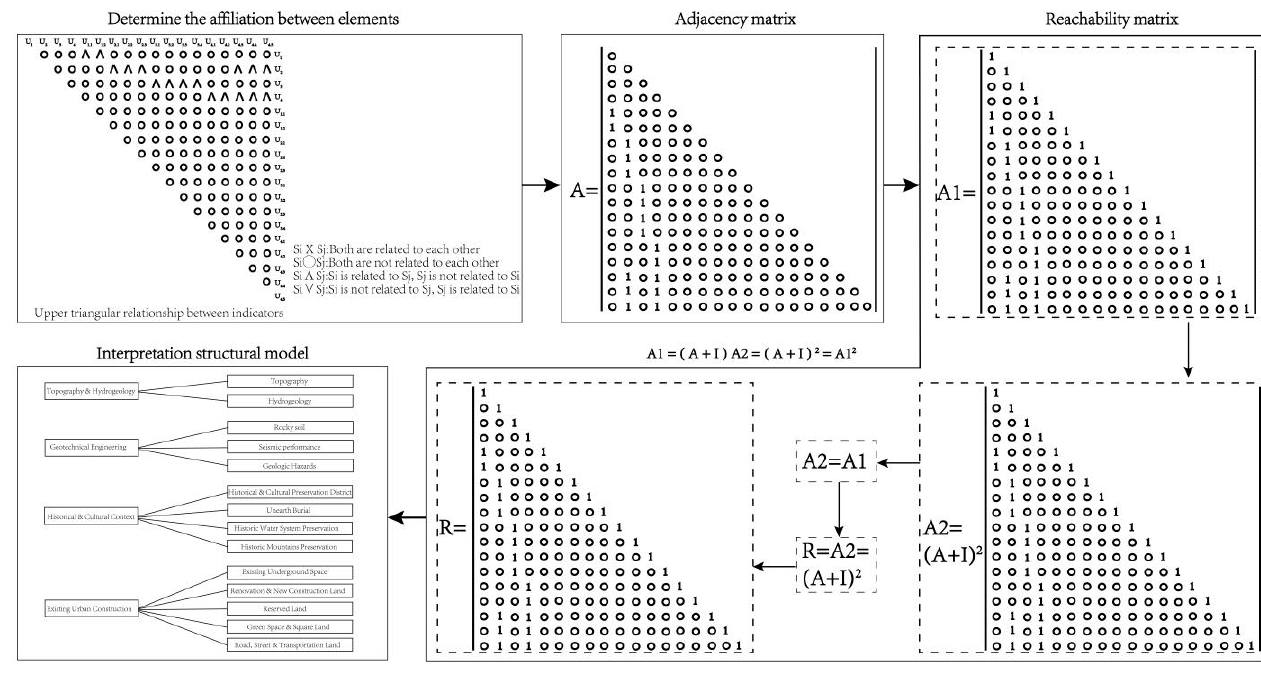
Figure 5. ISM method flow chart. Table 1. Suitability evaluation index of USR.